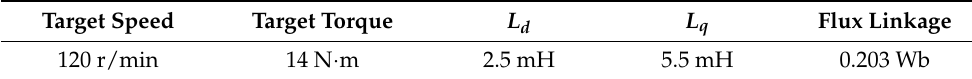
Table 2. Simulation